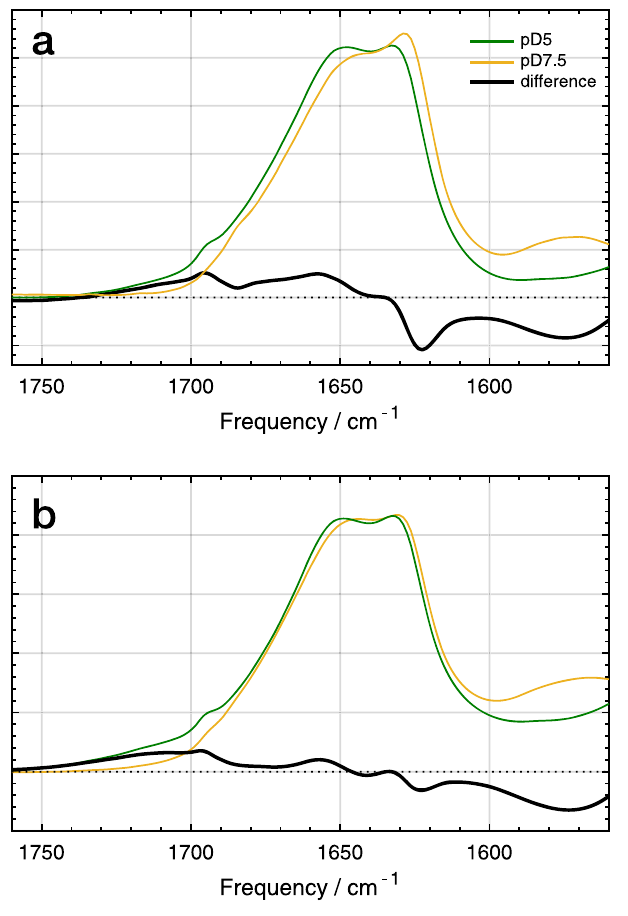
Fig. 3 FTIR spectroscopy of PsbS. FTIR spectra of WT PsbS and the M2 (E176Q) mutant. a FTIR spectra of WT PsbS at pD 7.5 (orange), pD 5.0 (green), and the difference spectra of pD 5.0 minus 7.5 (black). b FTIR spectra of the M2 (E176Q) mutant at pD 7.5 (orange), pD 5.0 (green), and the difference spectra of pD 5.0 minus 7.5 (black). All spectra were taken in D 2 O buffer. 100 – 150 scans were taken in one acquisition of each pD and repeated 10 times. 6 and 3 protein samples were investigated for WT and M2 mutant, respectively, of which one is shown for each